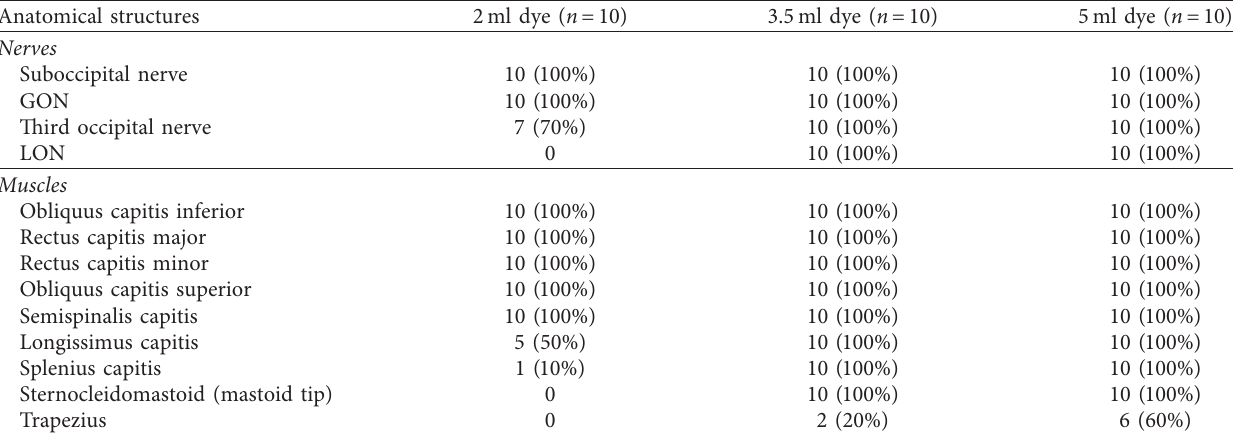
Table 1: Comparison of dye staining between suboccipital compartment block with 2, 3.5, and 5ml of methylene blue. Anatomical